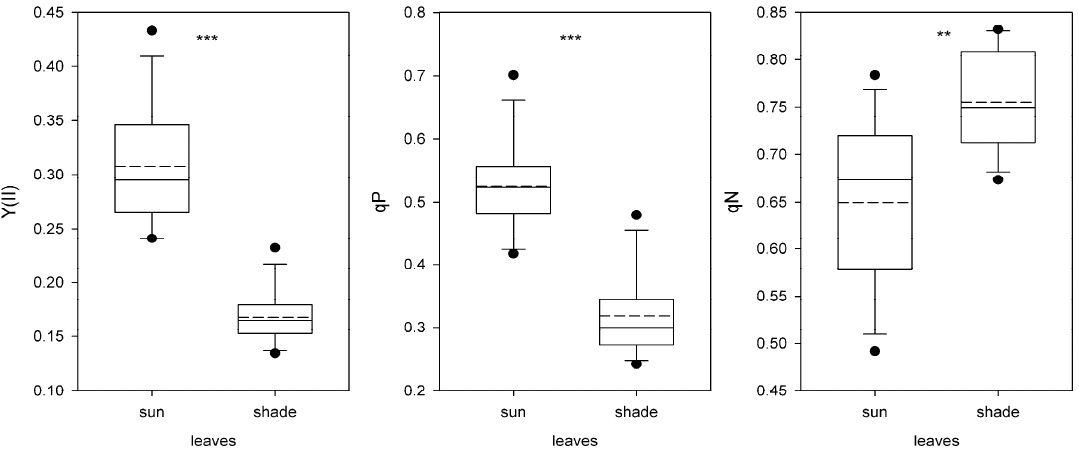
Figure 4. The quantum yield of PSII (Y(II)), photochemical (qP) and non-photochemical (qN) quenching for the sun and shade leaves of Phragmites australis in dense patches. Boxes encompass the 25% and 75% quartiles of all the data, the central solid and dashed lines represents the median and the average, bars extend to the 95% confidence limits, and dots represent outliers. For all bars n = 15. Di ff erences were tested with the Mann–Whitney Rank Sum Test; ** indicates p < 0.01, while *** indicates p < 0.001. These changes in photophysiological properties also appear on the reflectance of leaves a ff ecting primarily the red-edge and the near-infrared (NIR) spectral regions. Figure 5 presents the leaf reflectance spectra between 400 nm and 1000 nm measured for sun and shade leaves of Phragmites . The reflectance in the NIR (700–1000 nm) spectrum for sun leaves was 6.5% higher compared to the shade leaves. The red edge inflection point shifted to a shorter wavelength from λ p = 713 nm for the sun leaves to λ = 701 nm for the shade p